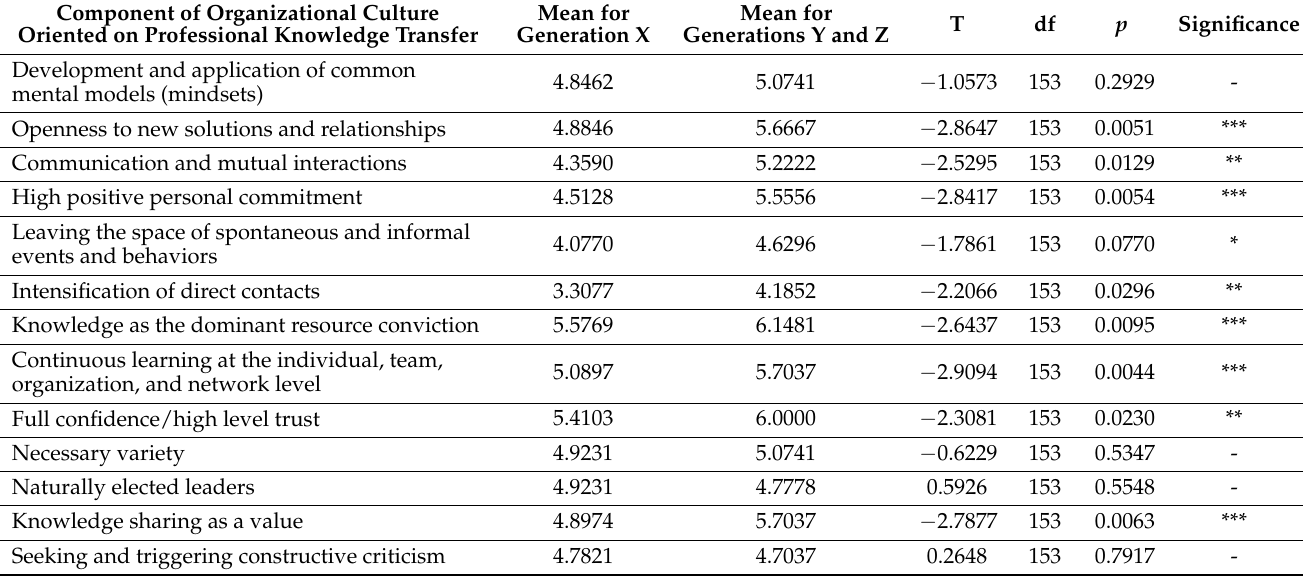
Table 7. T -test for variables of organizational culture oriented on professional knowledge exchange between professionals and personnel in terms of